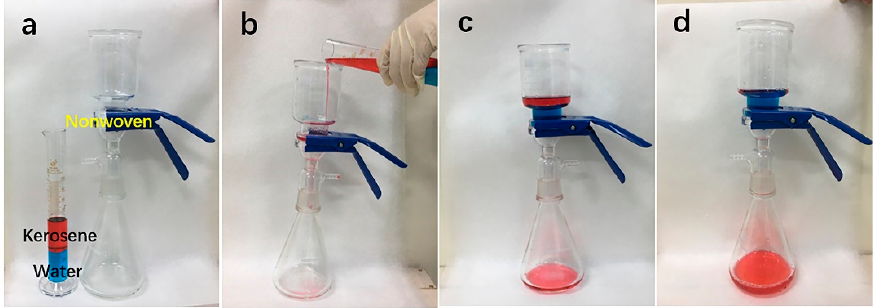
Figure 6. The oil-water separation process of M-PP / TiO 2 .